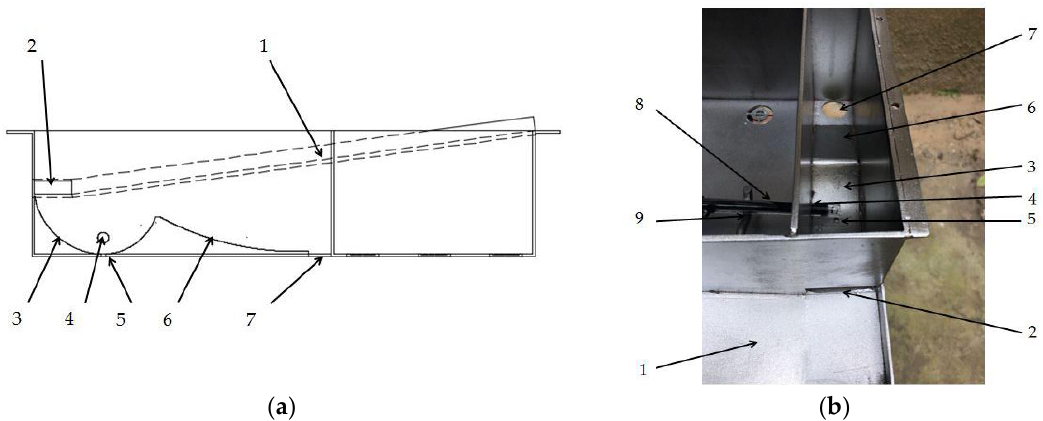
Figure 8. The device of rainwater collection and discharge: ( a ) picture of the structure; ( b ) picture of real product: (1) groove of rainwater collection; (2) drain outlet; (3) rainwater storage tank; (4) fixed orifice; (5) drain hole; (6) drainage trough; (7) drain hole; (8) pH sensor; (9) fixed collar.